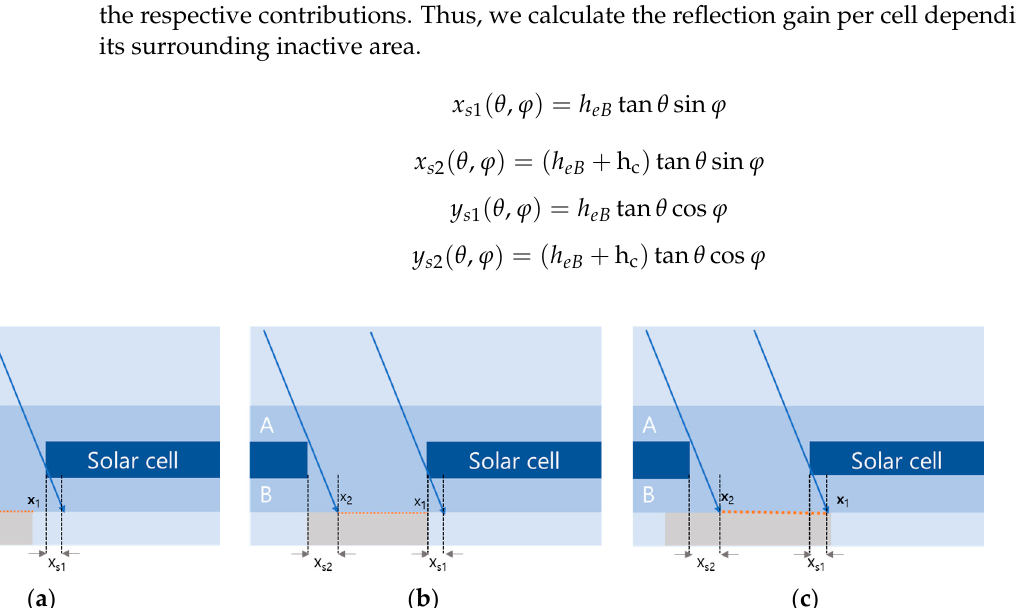
Figure 6. Illuminated area depending on the width of the coated backsheet area: ( a ) width is smaller than the cell distance; ( b ) width is the same as the cell distance; ( c ) width is larger than the cell distance. The dotted red line indicates the area on the coated backsheet where light redistribution needs to be considered; it is defined by the boundaries x 1 and x 2 .